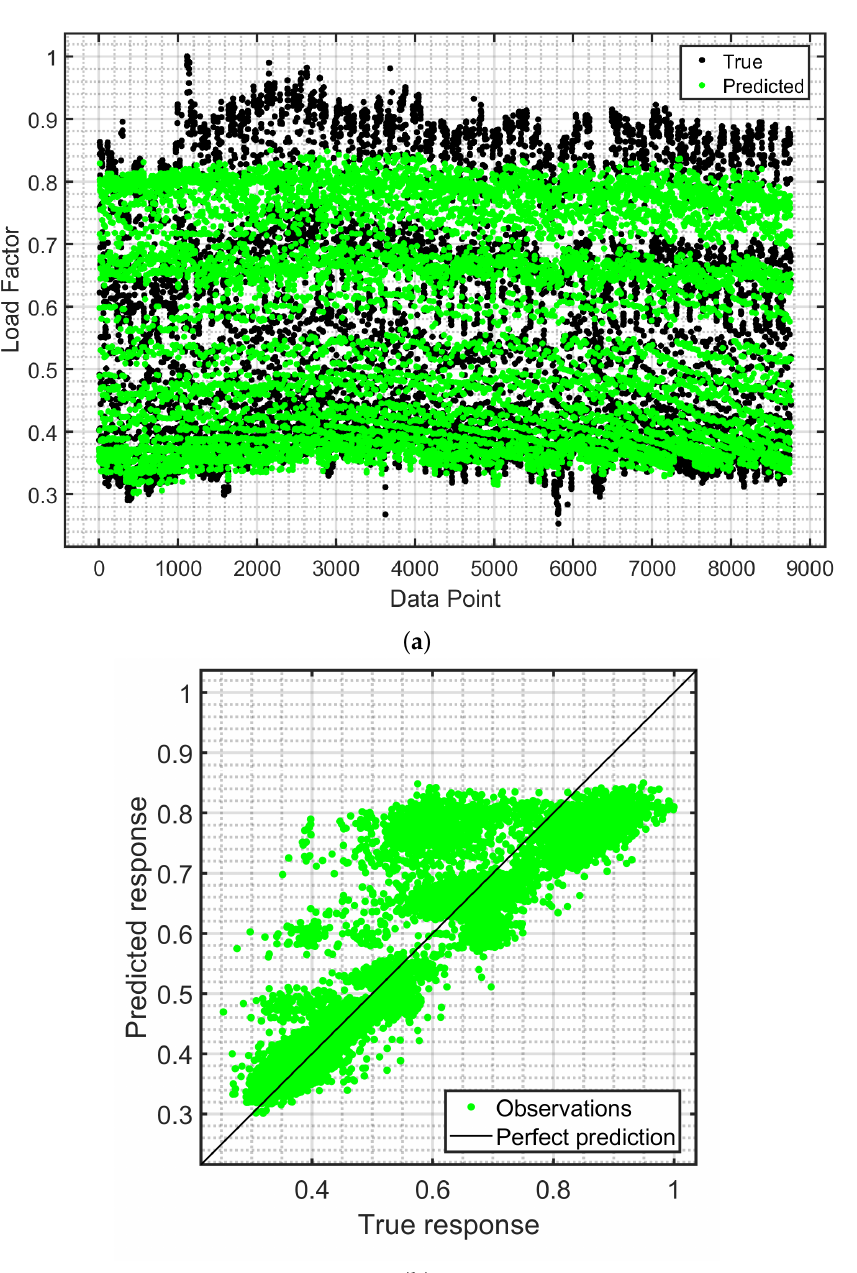
Figure 10. Results with Linear Regression. ( a ) Actual versus predicted values of Linear Regression. ( b ) Linearity analysis of Linear